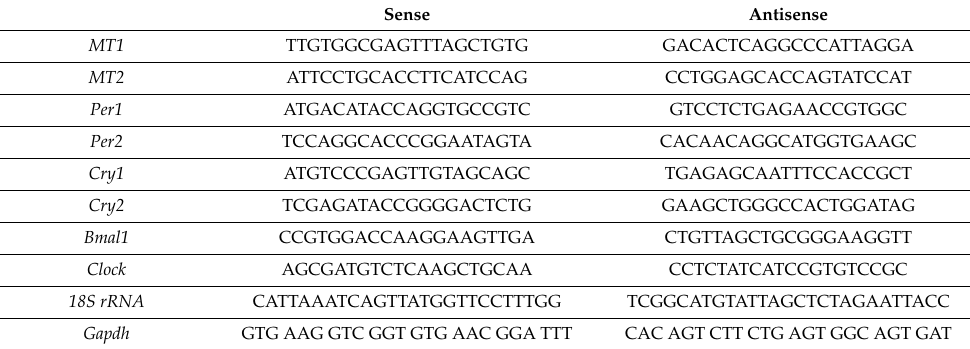
Table 1. Gene-specific primers used in this